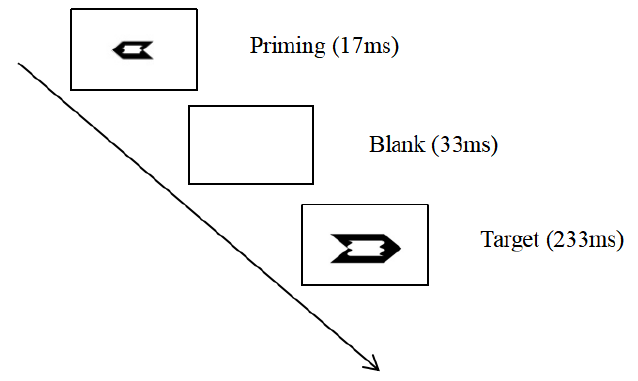
Figure 1. Experimental